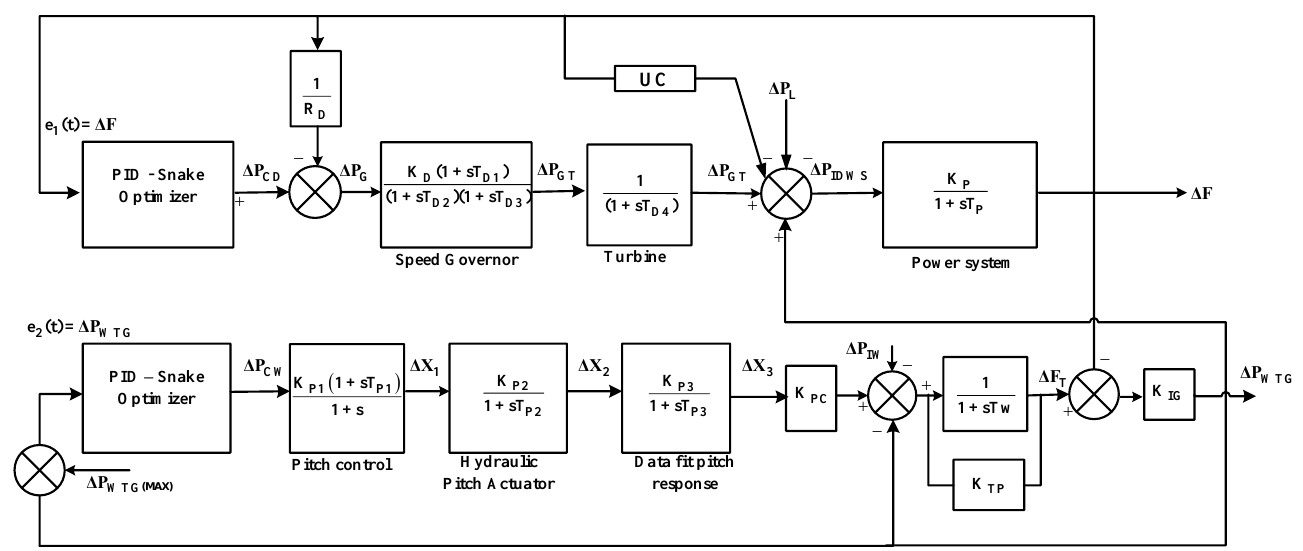
Figure 3. Diesel–wind isolated system with UC.